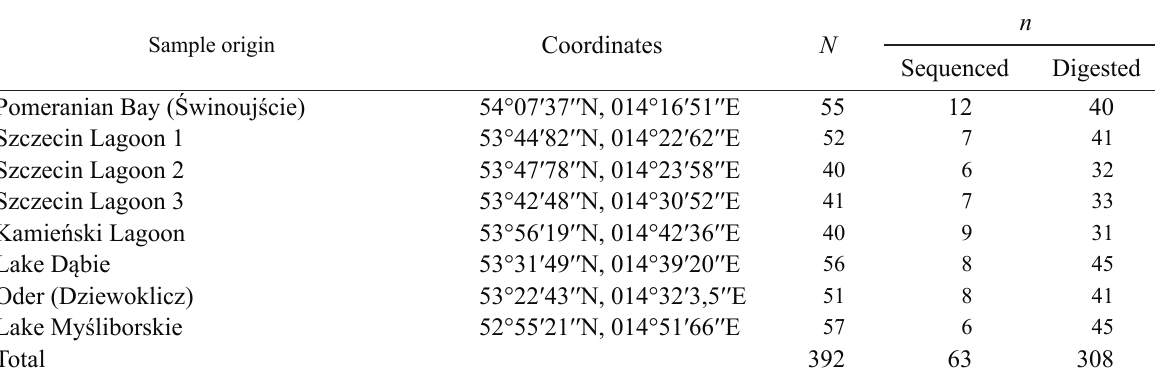
The number of individuals of perch, Perca fluviatilis , from which isolated tissues for genetic analysis were